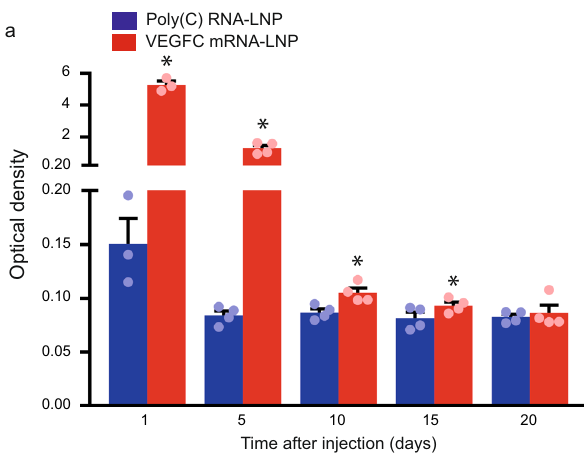
Fig. 1 Administration of VEGFC mRNA-LNPs induces VEGFC secretion in vivo. a 1 µ g of Poly(C) or VEGFC mRNA-LNPs were injected into contralateral ears of mice intradermally. Interstitial fl uid samples were harvested 1, 5, 10, 15, and 20 days post injection and VEGFC protein expression levels were determined by ELISA. Quantitative data for secreted amount of VEGFC are represented as mean and SEM from Poly(C) or VEGFC mRNA-LNP injected ears of 3 – 4 mice at each time point (two- tailed, paired T -test, P = 0.0023 after 1 day for 3 mice, P = 0.0063 after 5 days for 4 mice, P = 0.0017 after 10 days for 4 mice, P = 0.0332 after 15 days for 4 mice, and P = 0.7025 after 20 days for 4 mice). Asterisks indicate P < 0.05 compared with